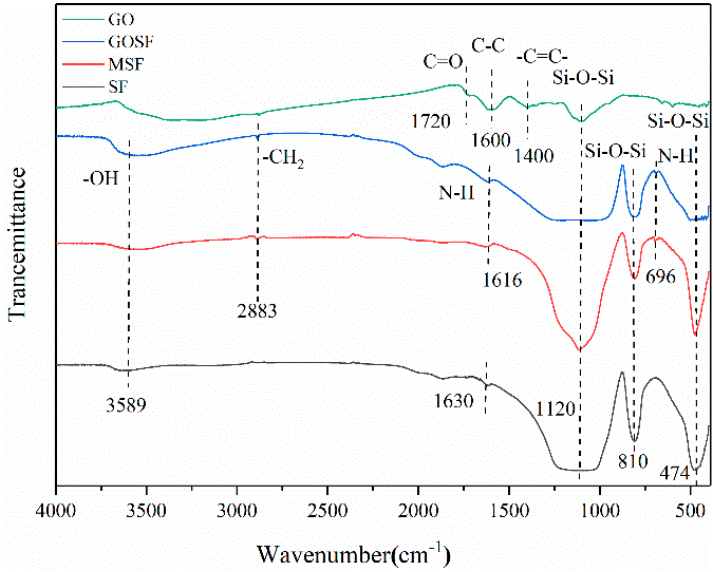
Figure 5. FT-IR patterns of SF, MSF, GO, and GOSF.